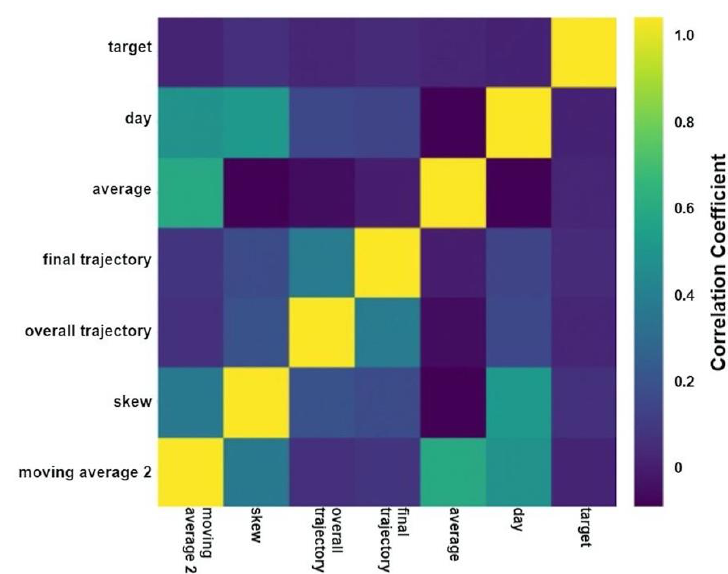
Figure 6. Feature Importance Plot.